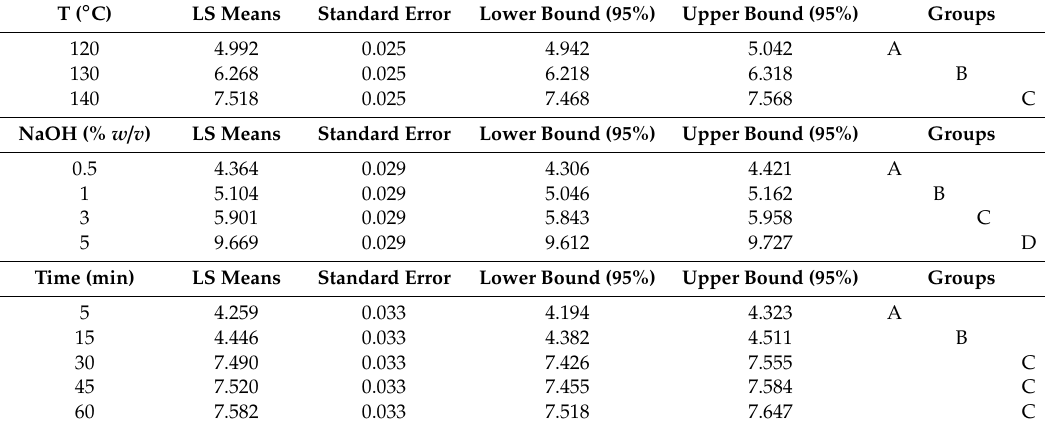
Table 4. Tukey’s HSD test results for the MW-A + sulfolane-TiO 2 pretreatment in relation to the saccharinic acids yield (g / L). Analysis of the di ff erences between the categories with a confidence interval of 95% for: temperature (top), NaOH concentration (center) and time